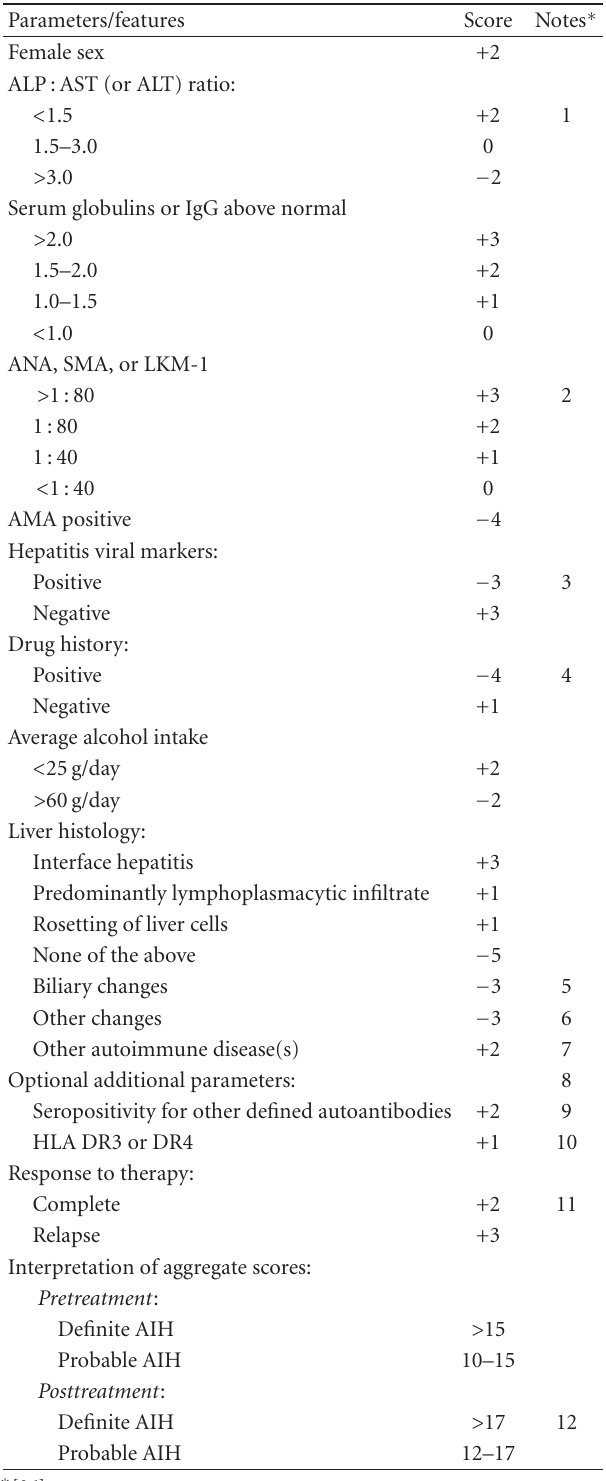
Table 1: Revised scoring system for the diagnosis of autoimmune